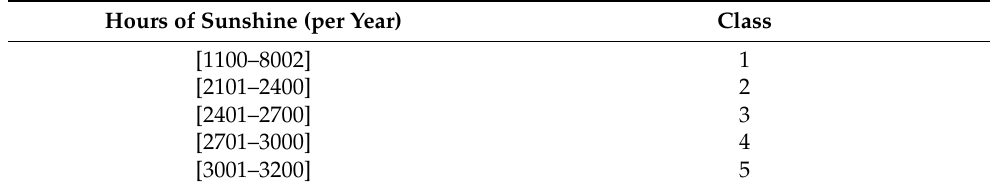
Table 3. Class division for insolation (IS), depending on the hours of sunshine per year for each cell. Hours of Sunshine (per Year)